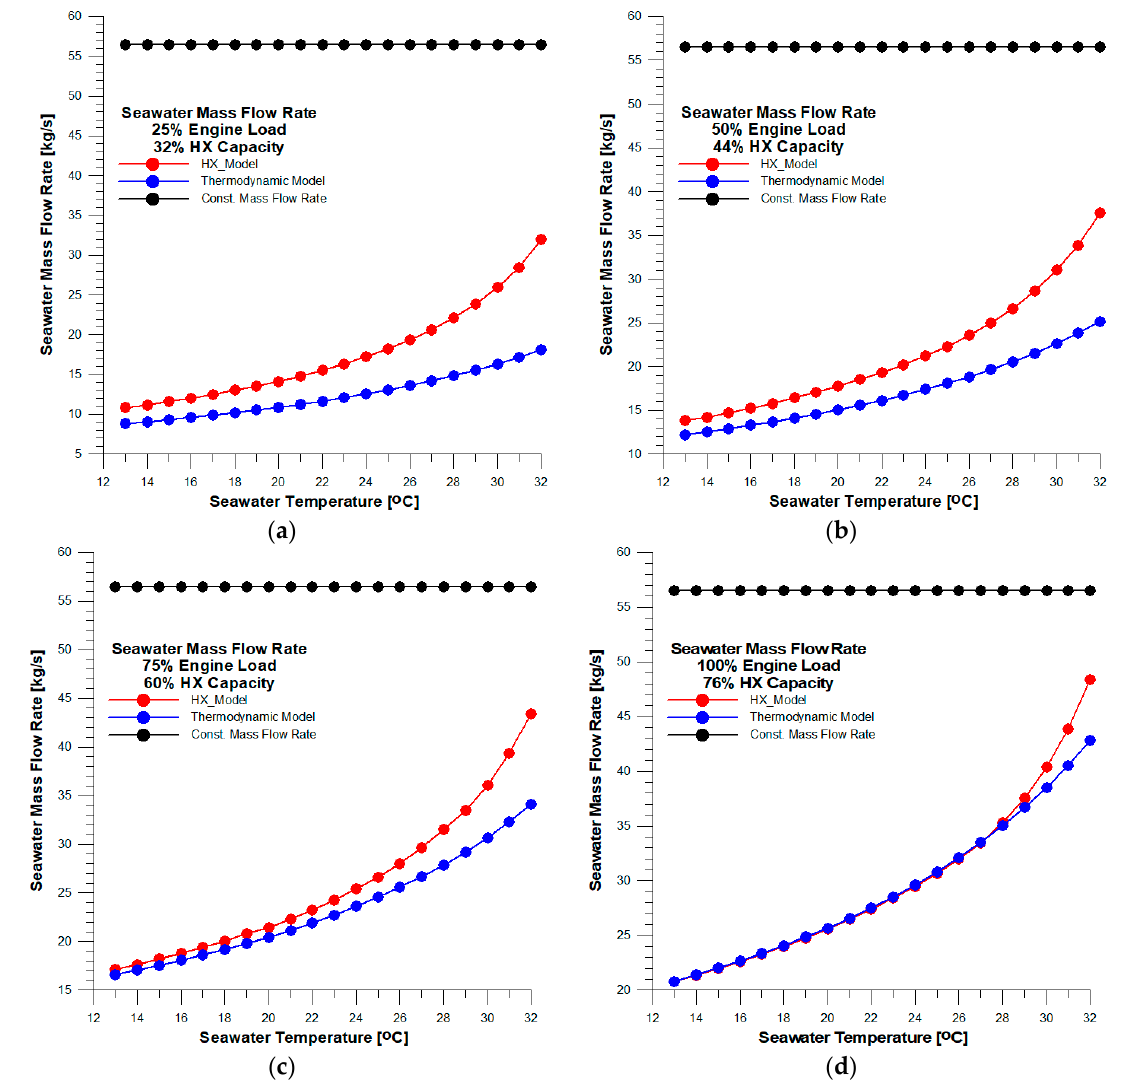
Figure 6. Comparison of seawater mass flow rates as a function of the SW inlet temperature (T t1 ), for central cooler capacities corresponding to ( a ) 25%, ( b ) 50%, ( c ) 75% and ( d ) 100% of full engine load, with VSD scheme and constant pump speed.